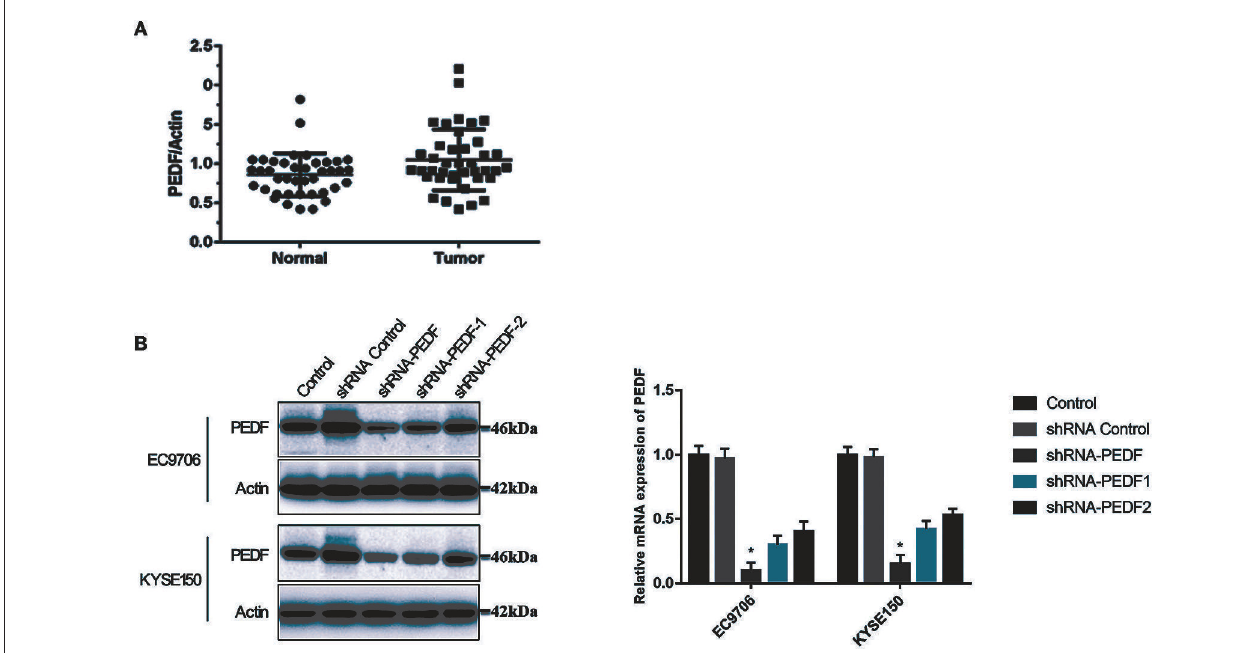
FIGURE 2 | Effect of PEDF knockdown on anchorage-independent growth of esophageal cancer cells. (A) Colony formation assay, and (B) invasion assay, of esophageal cancer cells after knocking down PEDF. * < 0.05.